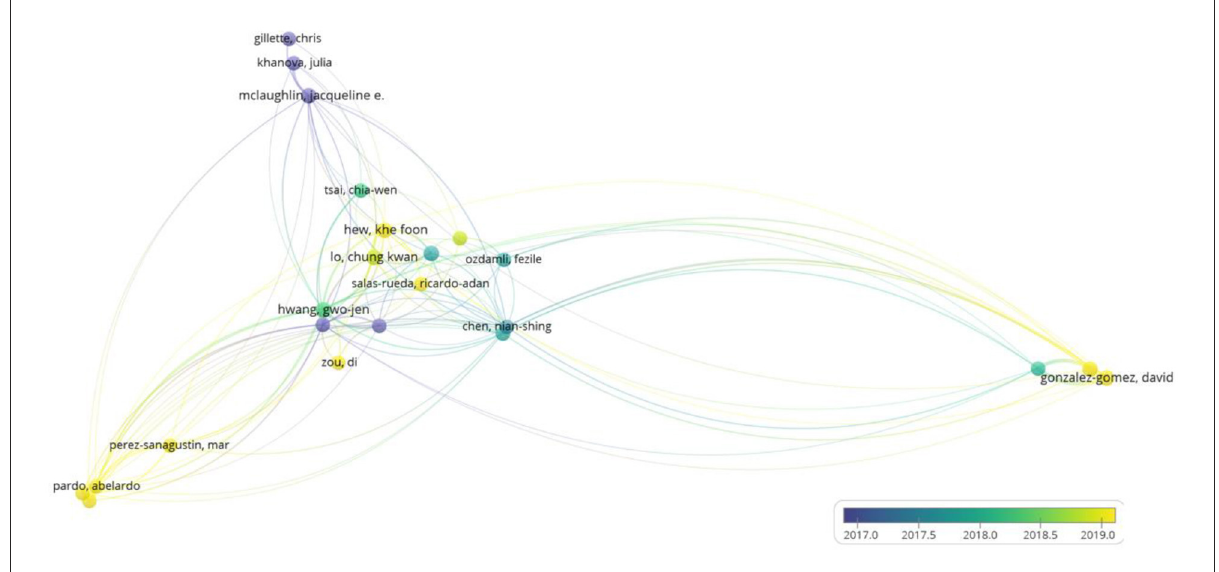
FIGURE6 Web of progress of publications of the most-cited authors. Source: Created by authors with VosViewer.